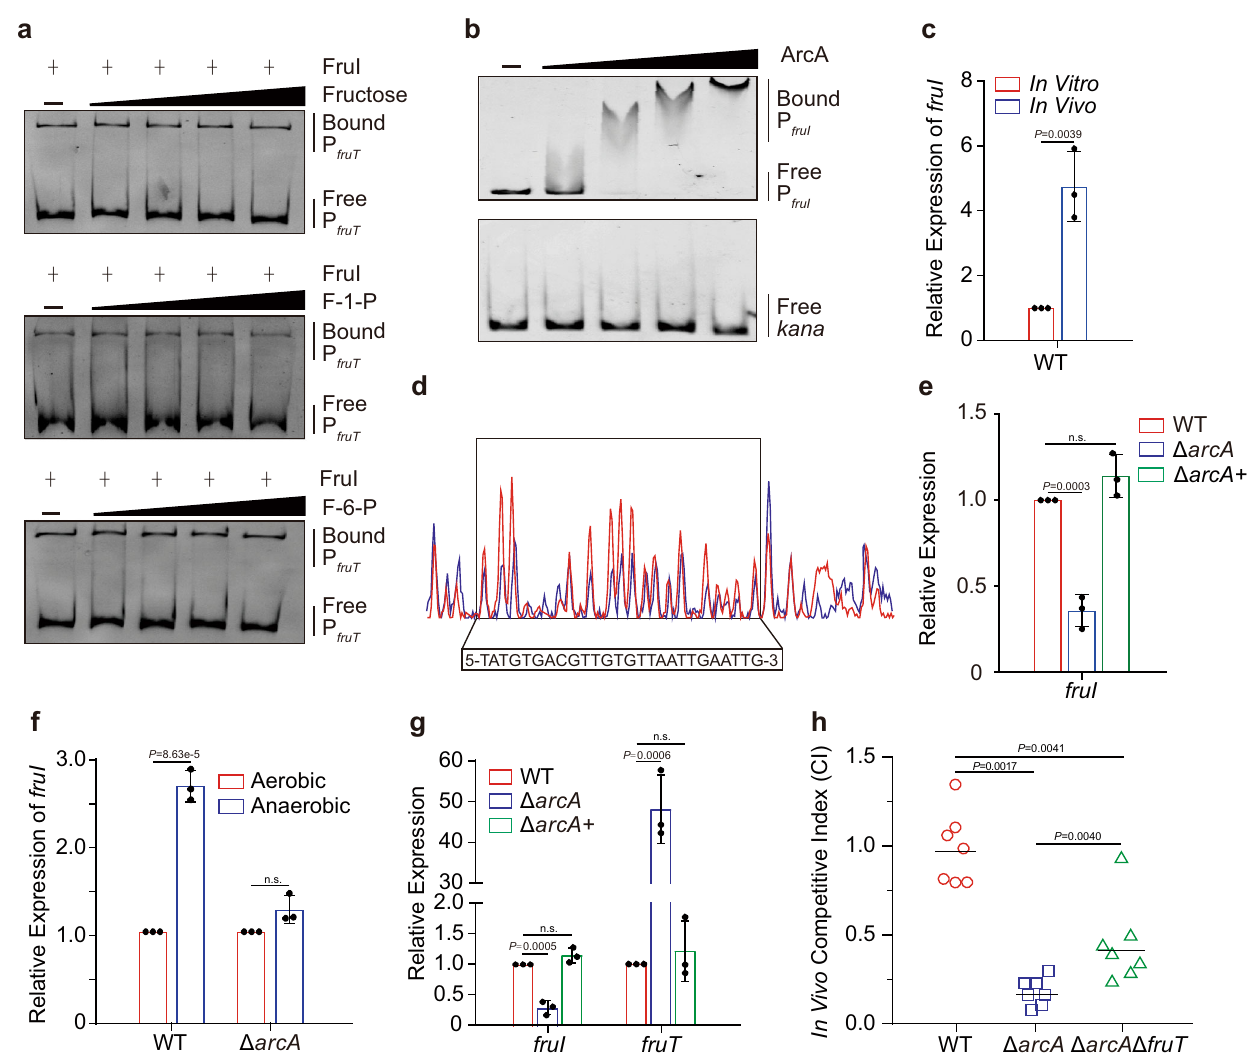
Fig. 4 fruI expression is induced by a low O 2 signal in the small intestine via ArcA. a The in fl uence of fructose, fructose-1-phosphate (F-1-P) and fructose-6-phosphate (F-6-P) on the binding of puri fi ed FruI protein to the promoter region of fruT . EMSAs of 0.2 μ M puri fi ed FruI protein complexed with 30 ng of the DNA fragment in the presence of different concentrations of putative effectors (0 – 10 mM) were conducted. b EMSA of the binding of puri fi ed ArcA protein to the promoter region of fruI and kana (negative control). c qRT-PCR expression level of fruI in WT in the small intestine of mice and M9 medium containing 20 mM fructose as the only carbon source. Data represent the mean ± SD ( n = 3). d ArcA binds to a motif in the fruI promoter region. The protected region shows a signi fi cantly reduced peak intensities (blue) pattern than seen in compared with those of the control (red). The identi fi ed FruI-binding motif is shown in a box at the bottom of the fi gure. e qRT-PCR expression level of fruI in WT, Δ arcA and Δ arcA + in M9 medium containing 20 mM fructose as the only carbon source. Data represent the mean ± SD ( n = 3). f qRT-PCR expression level of fruI in WT and Δ arcA in M9 medium containing 20 mM fructose as the only carbon source under anaerobic conditions or aerobic conditions. Data represent the mean ± SD ( n = 3). g qRT-PCR expression level of fruI and fruT in WT, Δ arcA , and Δ arcA + in mouse small intestine. Data represent the mean ± SD ( n = 3). h Competition assay comparing the colonizing ability of WT, Δ arcA , and Δ arcA Δ fruT in infant mouse intestine ( n = 7 mice per group). CI is de fi ned as the output ratio of mutant strains to WT lacZ - divided by the input ratio of mutant strains to WT lacZ -. Each symbol represents the CI in an individual mouse; horizontal bars indicate the median. Images are representative of three independent experiments ( a , b ). Signi fi cance is determined by two-tailed unpaired Student ’ s t test ( c , e – g ) or two-sided Mann – Whitney U test ( h ) and indicated as the P value; n.s. means no signi fi cant difference. Source data are included in Source Data fi